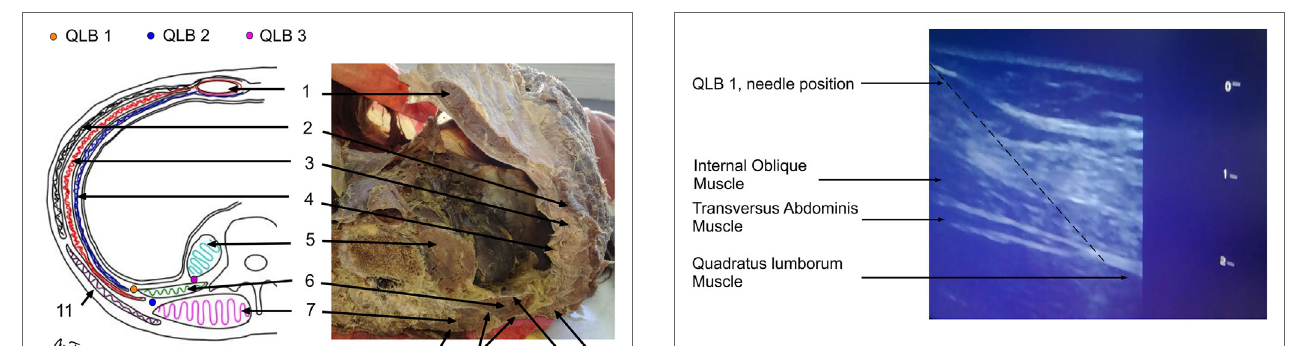
FiGURe 3 | Quadratus lumborum type 1 block—needle position.